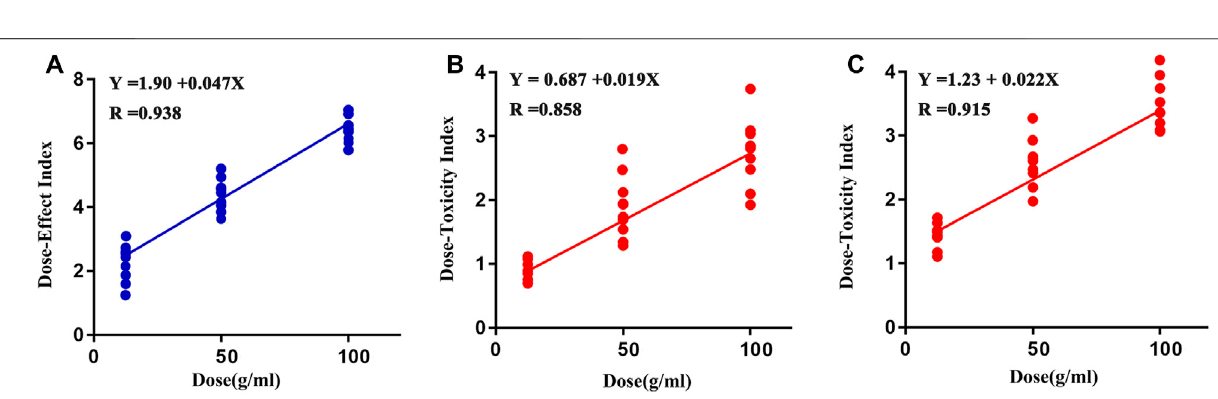
Frontiers in Pharmacology |